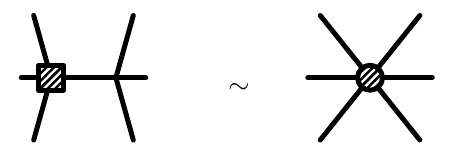
Figure 1 . Two schematic amplitudes whose dimension n parts are equal: the square and circle denote higher and lower derivative dimension n